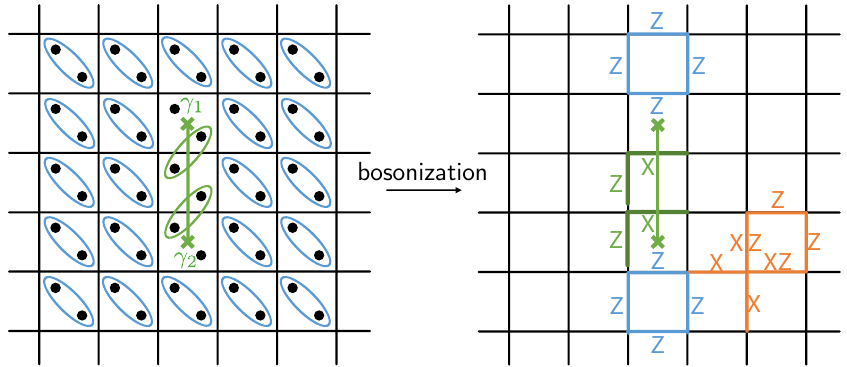
Figure 33: Left: The Kitaev chain is decorated on the open green line terminated at the two endpoints corresponding to the point defects (green crosses), which makes the Majorana fermion paired with the other one on its adjacent face; otherwise, Ma- jorana fermions are paired within each face and form an atomic insulator. Two un- paired Majorana fermion mode γ and γ are left on the two point defects respec- 1 2 tively. Right: after bosonization, the pairing term on the Kitaev chain becomes the hopping operator U on the open twist string, while the pairing term in each face not e on the open twist becomes the 4-body plaquette Z -stabilizers. Moreover, the 4-body plaquette Z -stabilizers are removed from the two plaquettes where the point defects (green crosses) are